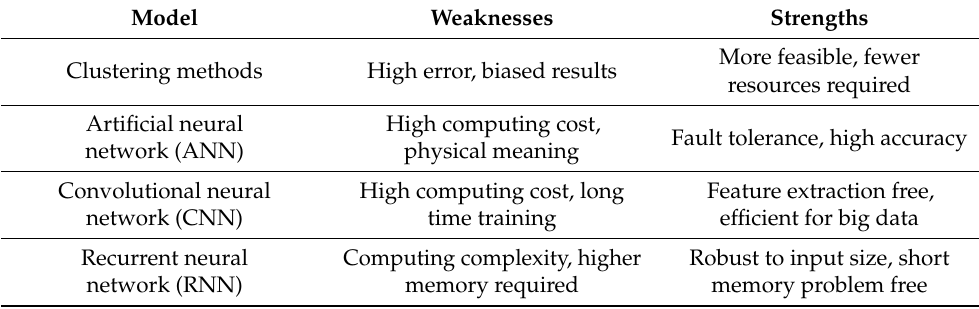
Table 8. ML algorithms features for Acoustic Emission